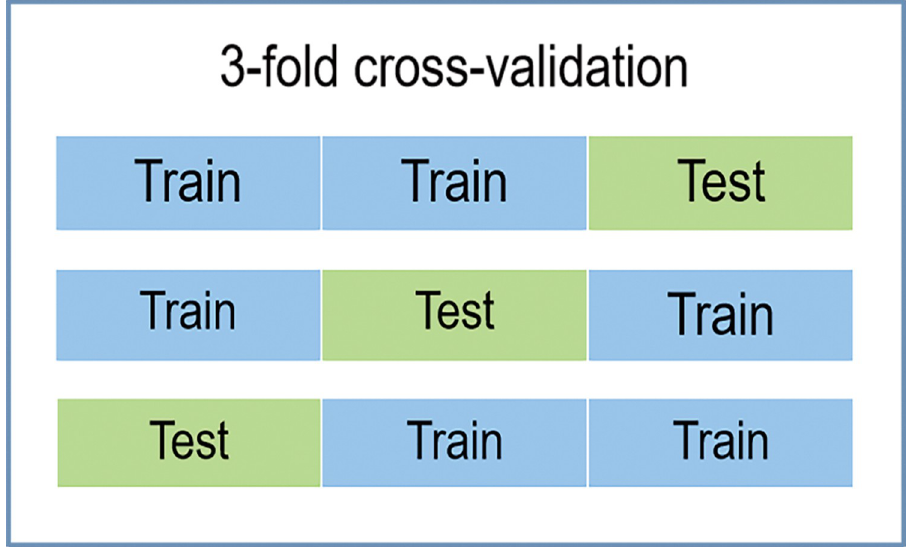
Fig 1. All ML models were cross-verified with 3 fold